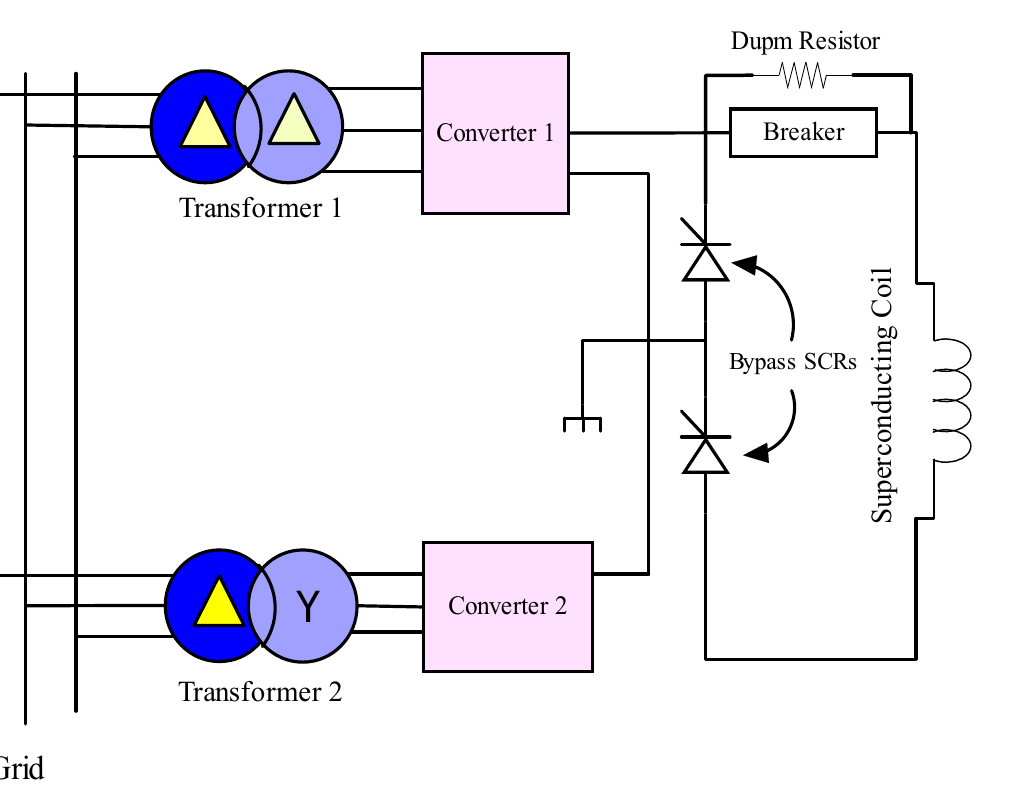
Figure 2. Structure of SMES unit.